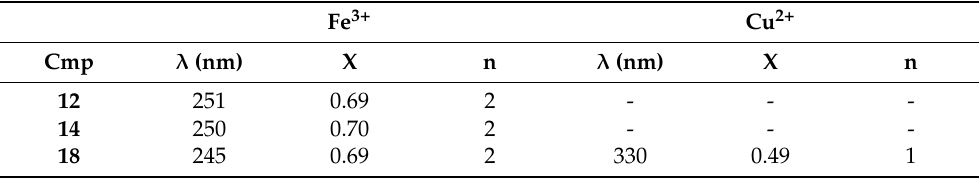
Table 5. Job’s plot data for the tested compounds ( 12 , 14 , 18 ) in presence of Fe 3+ and Cu 2+ . The table shows the wavelength values ( λ ) in which the absorbance variation was measured, the molar ratios (X) that cause the maximum variation of absorbance and the coordination values (n) which correspond to the number of ligand molecules per